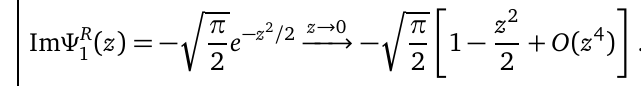
Figure 7: Left: Re [ Ψ R (red curve), Im [ σ R